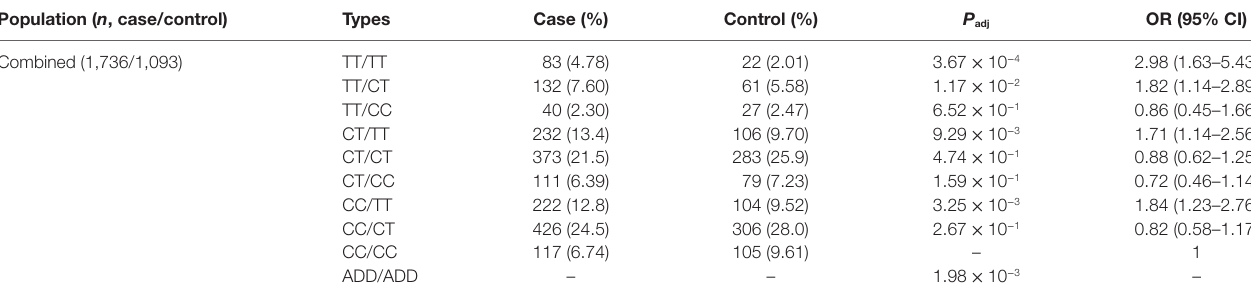
TaBle 4 | Interaction analysis between rs3806933 in thymic stromal lymphopoietin ( TSLP ) and rs7025417 in IL33 under the genotypic model in the combined population. Population ( n ,